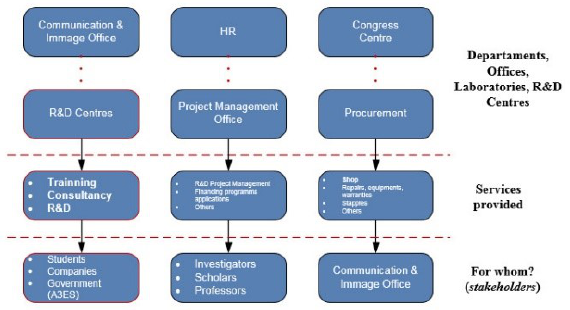
If, at the level of the organizational aspect, and taking this IES as an example, it is desired to make a correspon- dence between the different functional areas and the as- sociated stakeholders, it is verified that there is a diversity of stakeholders with different perceptions and quality re- quirements, ranging from according to the functional area to which they relate (Fig. 3).